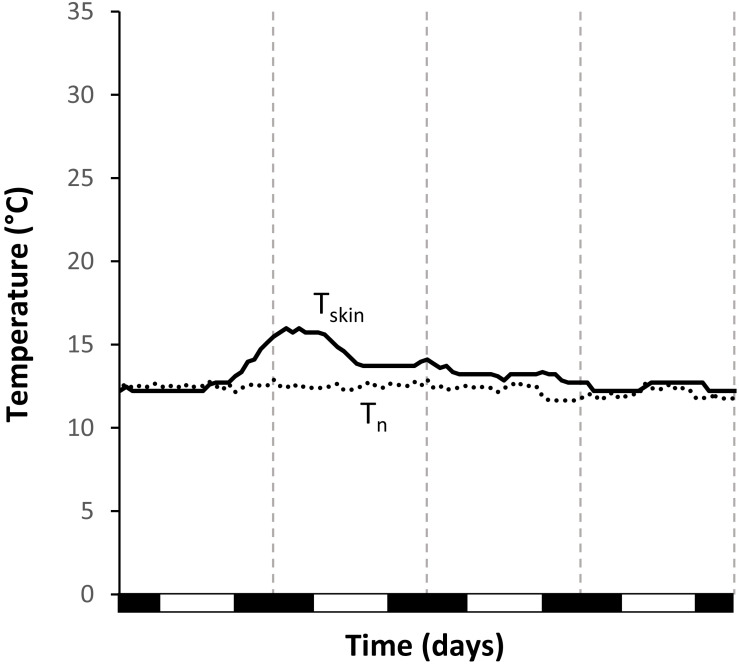
Unsuccessful attempt at rewarming from torpor of Echinops telfairi under constant temperature treatment in winter (Wconst12). During this event, skin temperature reached a maximum of only 14.7°C and only slowly returned to the level of nest box temperature over two days. Black line: skin temperature; dotted line: nest box temperature; vertical dashed lines indicate midnight, black boxes on the x-axis the scotophase.